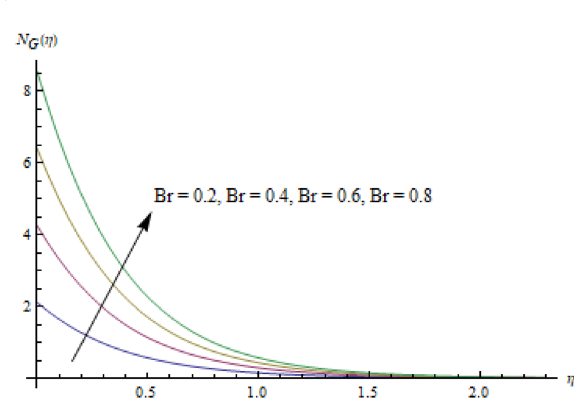
Fig. 37 Impact of θ w on N G (η)